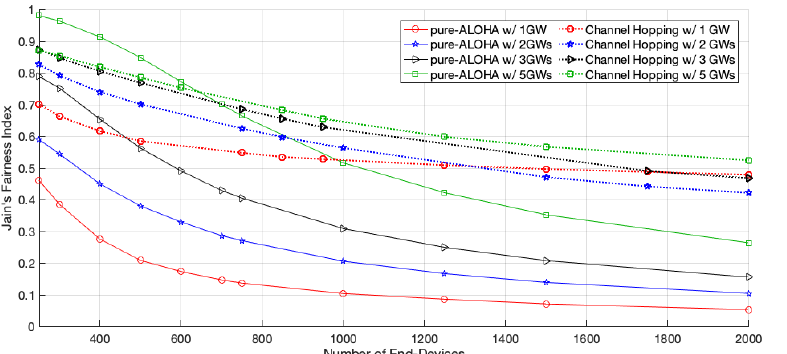
Figure 8. Jain’s network